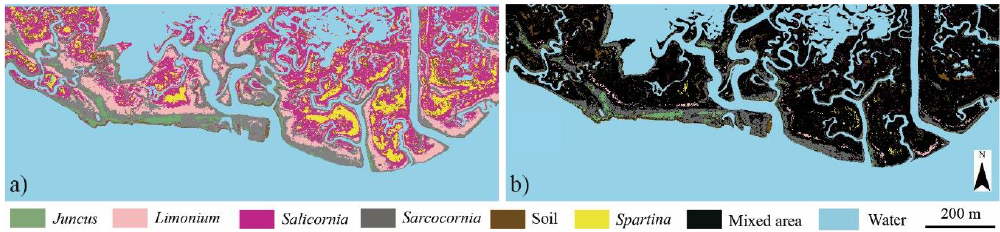
Figure 6. Maps for dominant species and soil: ( a) RF hard classification map results; ( b ) majority map based on RF soft classification. Table 5. Confusion Matrix for WV-2 classification of San Felice marsh through Random Forest (RF)